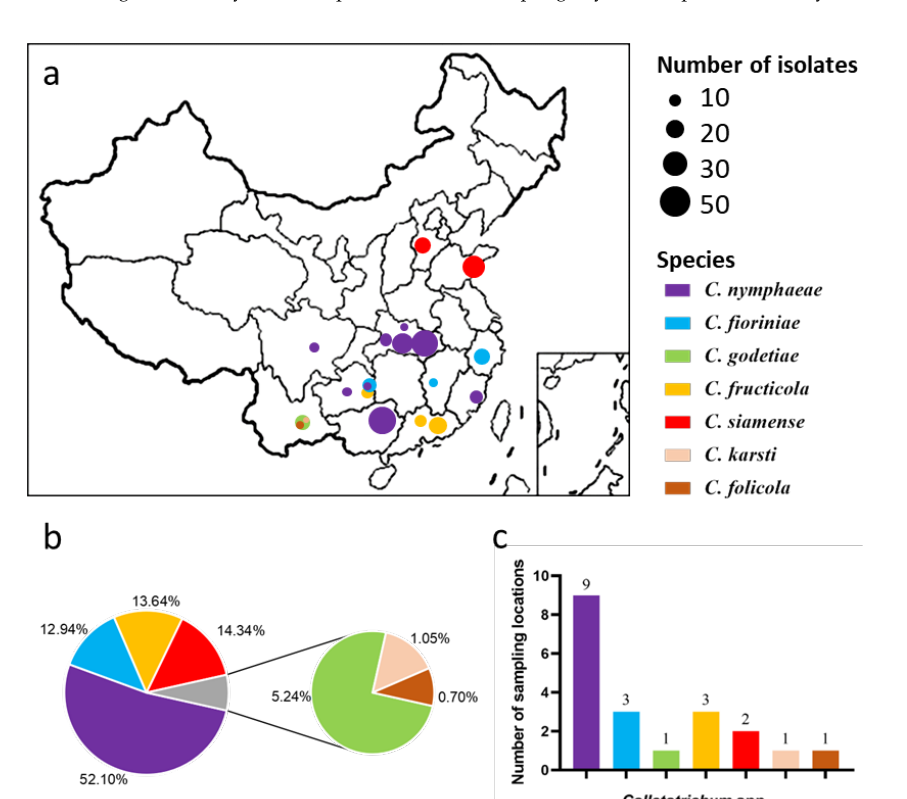
a The average of the daily mean temperatures on the sampling day and the previous six days.